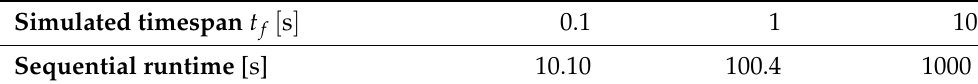
Table 3. Runtime of multi-level PinT compared to two-level and sequential time-stepping for the microgrid test case with four household-type elements. The results summarized here display the expected behavior of no convergence whenever the coarsest time-step does not align with the switching period. On the other hand, when alignment is given, the algorithm converges and, for higher coarsening factors and amounts of levels, speeds up the simulation somewhat.